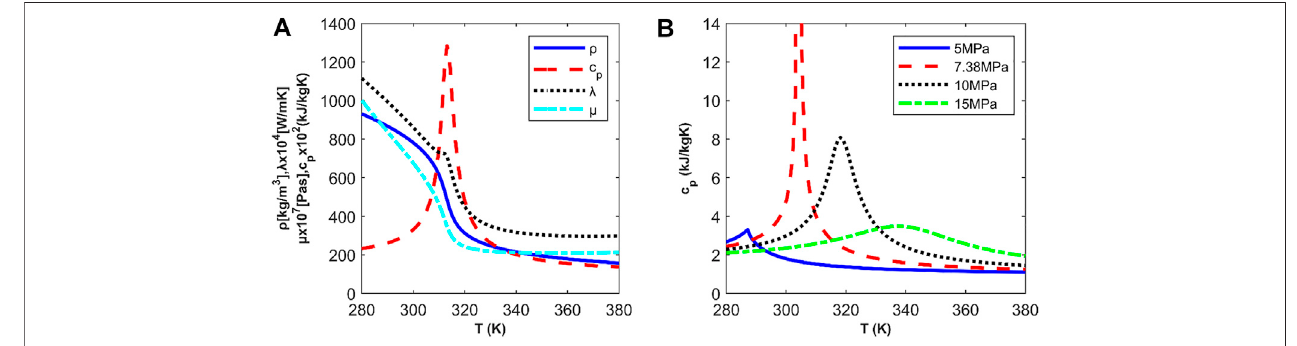
FIGURE 2 | Con fi gurations of single- fl ow sCO 2 Brayton cycles: (A) Recuperation; (B) Intercooling; (C) Reheating; (D) Inter-recuperation; (E) Pre-compression; (F) Split expansion (adapted from (Ahn et al., 2015)).